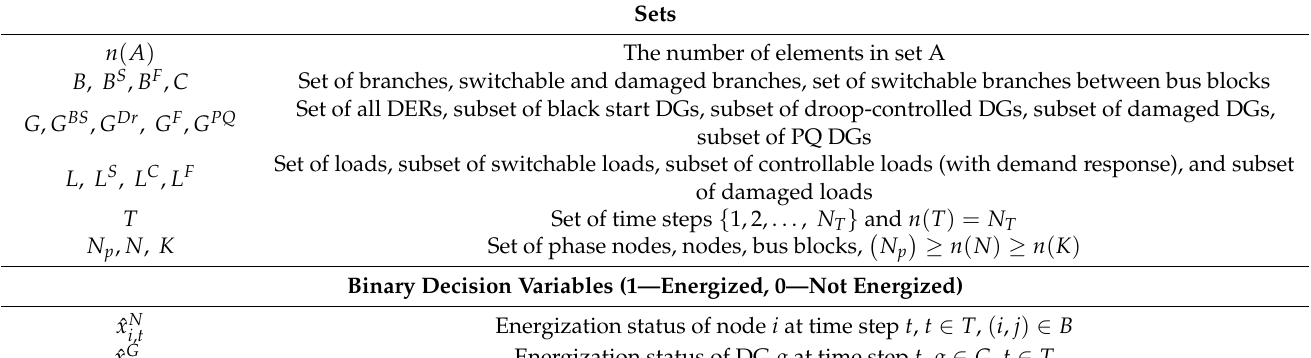
Table 1. Nomenclature and Parameters of the Proposed Restoration